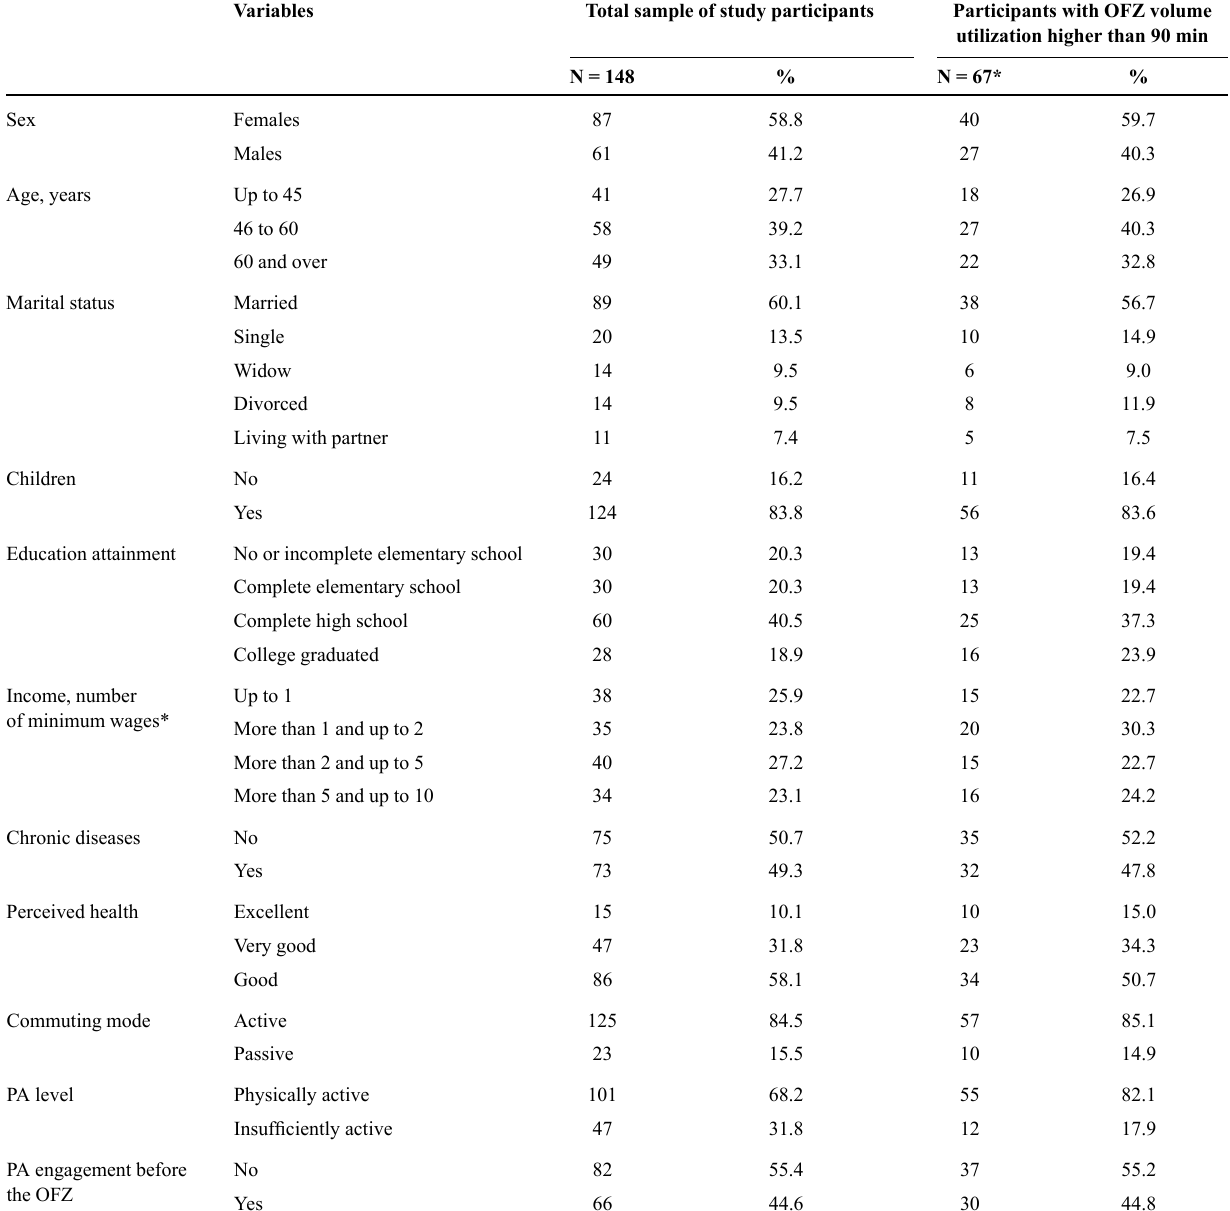
Table 2 - Descriptive characteristics of OFZ users discriminated by a total sample of study participants (n = 148) and participants with OFZ volume utili- zation higher than 90